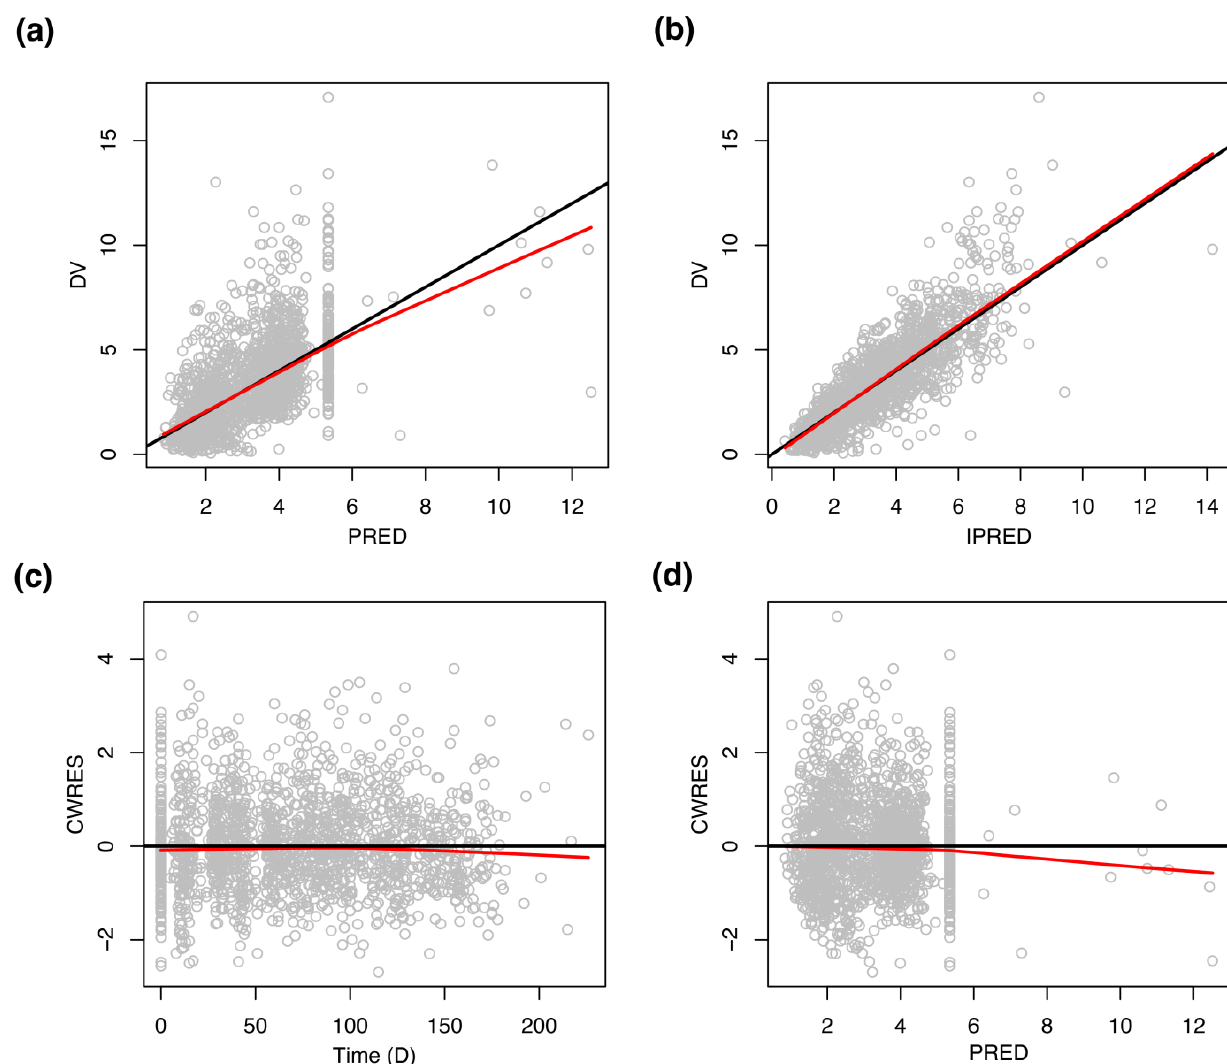
Figure 2. Goodness-of-fit plots of the final model. ( a ) Scatterplot showing DV (observations) vs. typical predictions (PRED). ( b ) Scatterplot showing DV (observations) vs. individual predictions (PRED). ( c ) Scatterplot showing conditional weighted residuals (CWRES) vs. time. ( d ) Scatterplot showing conditional weighted residuals (CWRES) vs. PRED. Black lines represent identity lines for ( a , b ) and zero residual lines for ( c , d ), and red lines represent smoother lines.